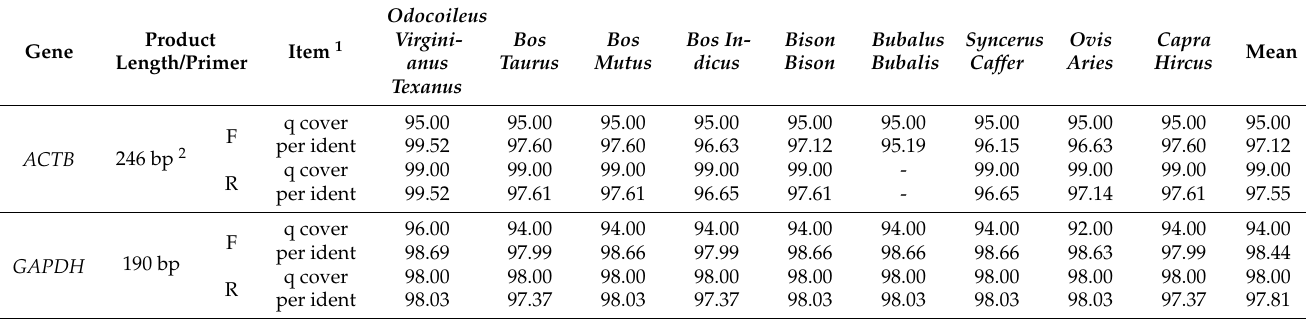
Table 3. Result of alignment of sequenced PCR reaction products with GenBank mRNA sequence database.